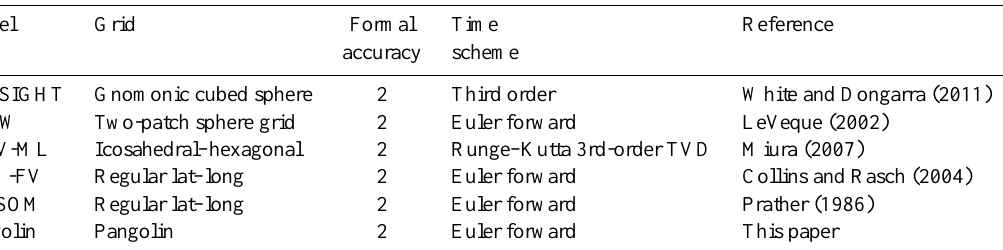
Table 2. Summary of the models used as a comparison: name, implementation grid, the total number of cells vs. Pangolin, and the time scheme.